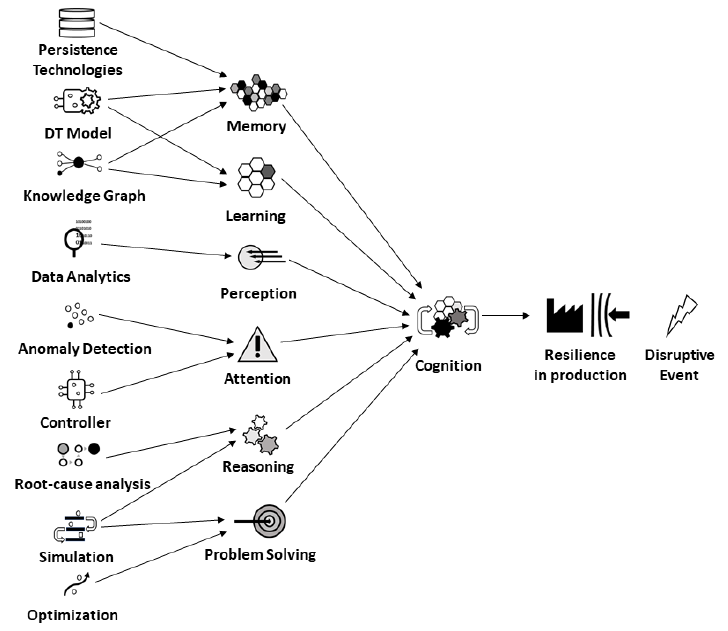
Figure 1. Resilience in production through cognitive capabilities enabled by specific CDT tools and services.